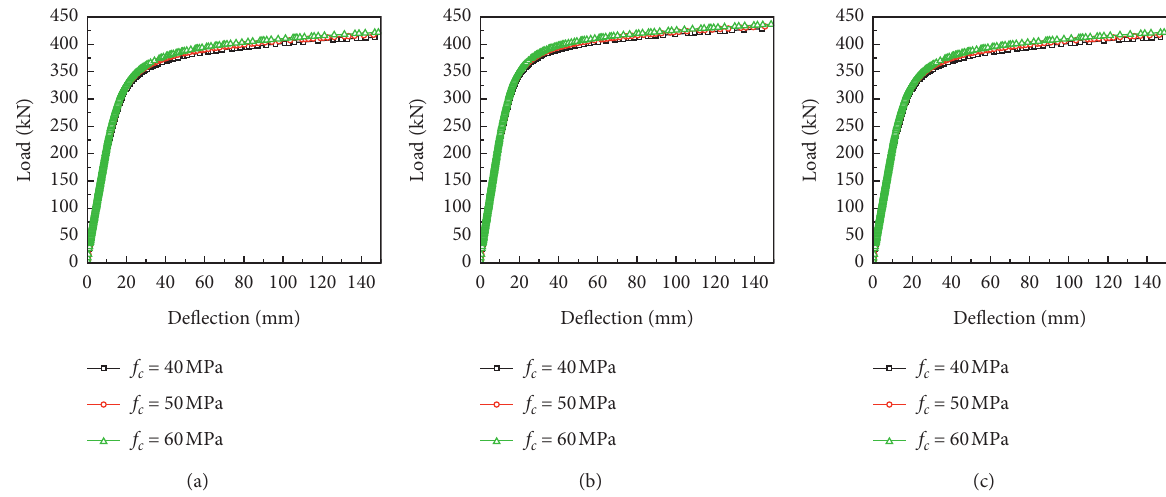
Figure 17: Load-deflection curves of the TGCB models with different concrete compressive strength: (a) outer girder G1 in curved TGCB models, (b) inner girder G2 in curved TGCB models, and (c) straight TGCB models.